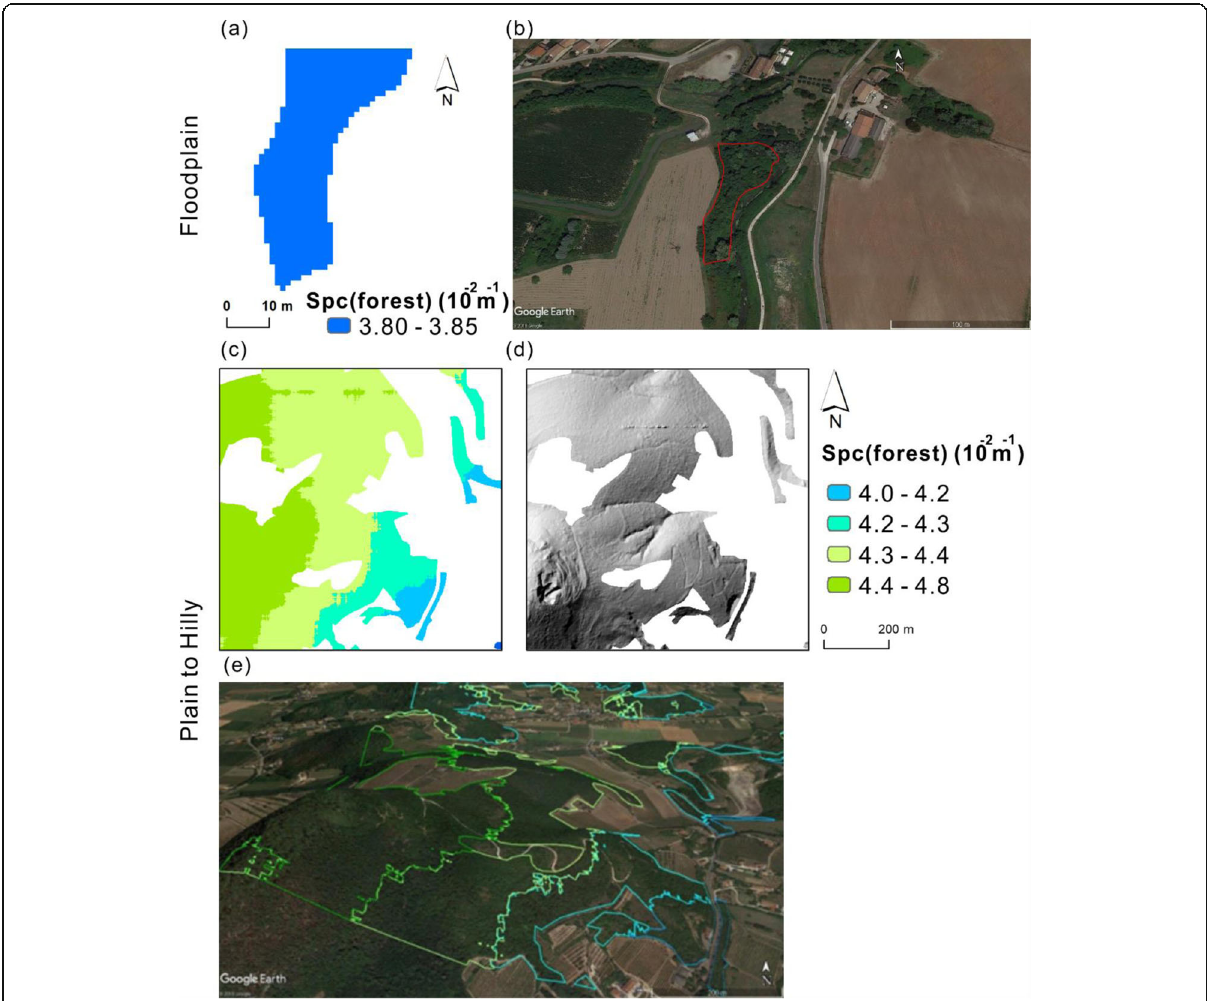
Fig. 14 Forest with Spc value in floodplain ( a ) and 3D overview ( b ) of the surrounding from Google Earth (the red outline extracted from forest); forest with Spc value in plain to hilly ( c ), LiDAR ( d ) and 3D overview ( e ); the outline with different colour denote the different Spc